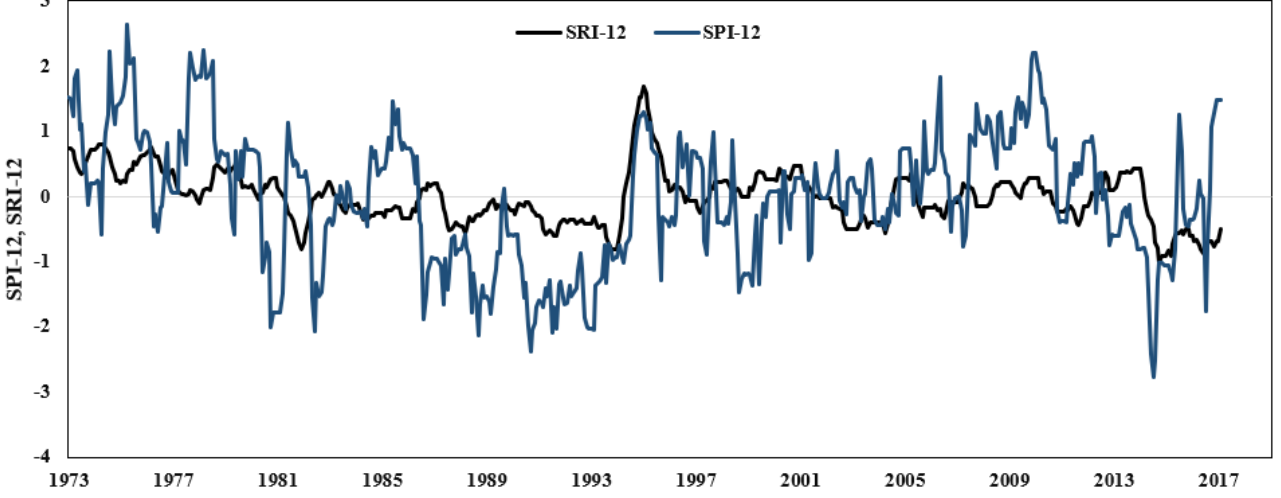
Figure 4. The SPI-12 and SRI-12 time series plot for the Wadi Ouahrane